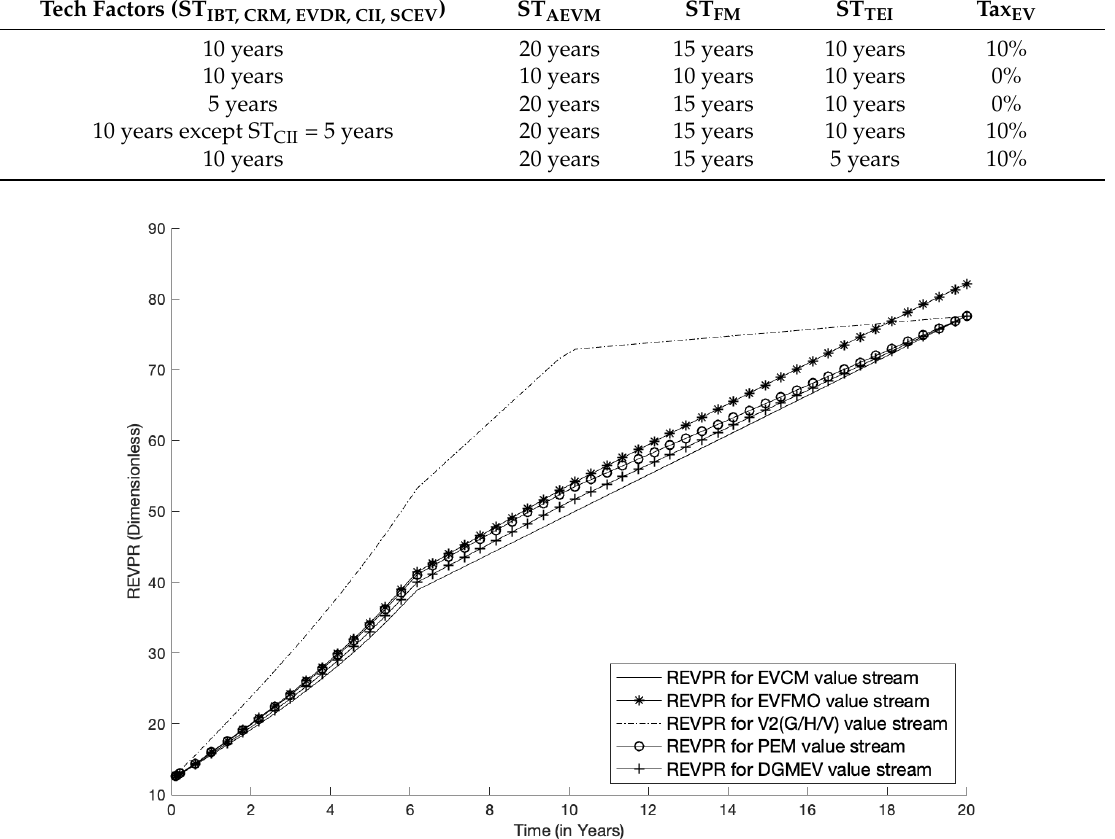
Figure 7. REVPR to achieve jurisdictional